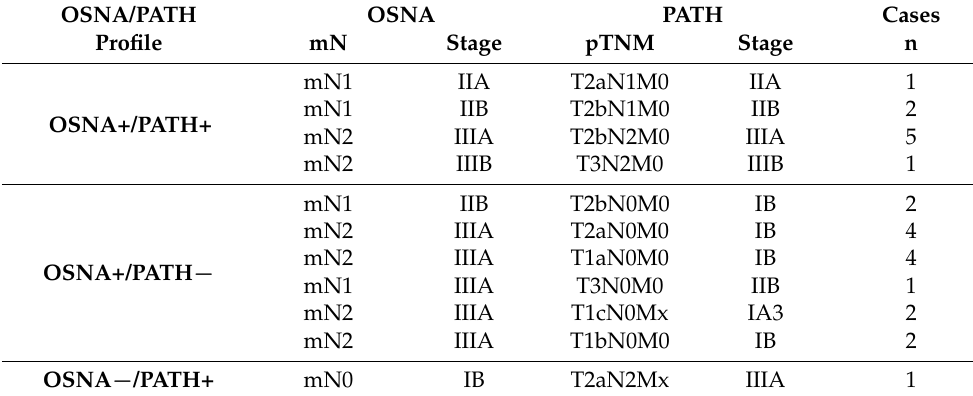
Figure 1. Venn diagrams comparing the different techniques (OSNA and PATH (H&E and IHC)) for detection of metastases in patients studied ( A ) and in their individual lymph nodes ( B ). The percentage is based on the total number of patients and LNs included in the study. Table 3. Changes in the pTNM staging depending on OSNA and PATH (H&E and IHC) results. eosin, IHC: